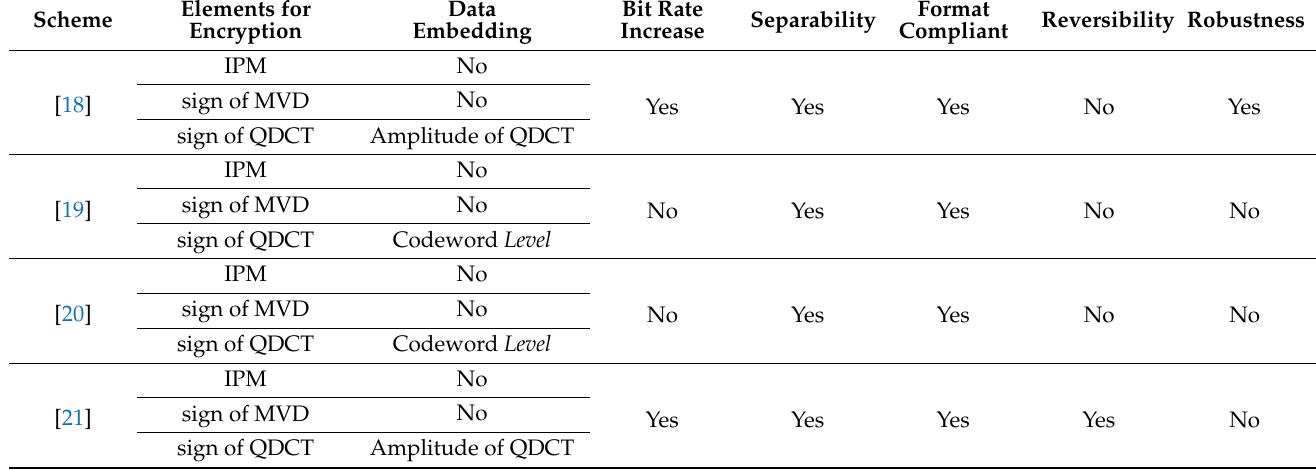
Table 5. Qualitative analysis of the related